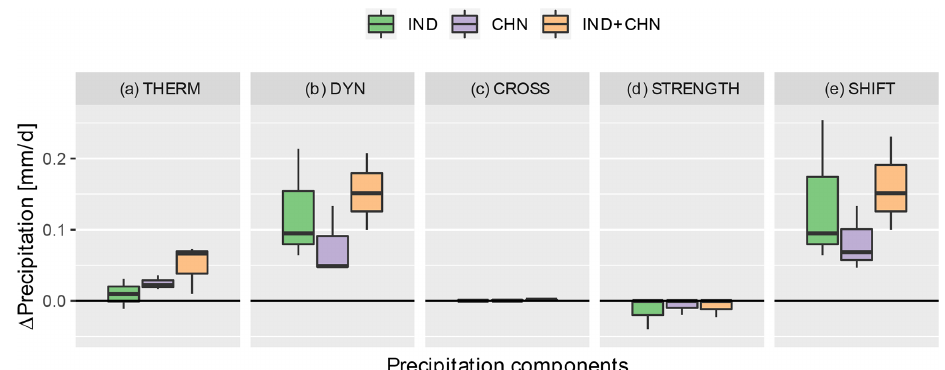
Figure 5. Boxplots indicating the decomposition of area-averaged JJAS precipitation anomalies [mmd − 1 ] into (a) (cid:49)P therm , (b) (cid:49)P dyn , (c) (cid:49)P cross , (d) (cid:49)P strength and (e) (cid:49)P shift components over India. Different colors represent the three RAEI scenarios relative to the respec- tive CTRL run, with green representing the IND NO SO 2 experiment, purple the CHN 20% SO 2 experiment and orange the IND + CHN NO SO 2 experiment. The range for each boxplot corresponds to intermodel variability from the three different models studied in the RAEI